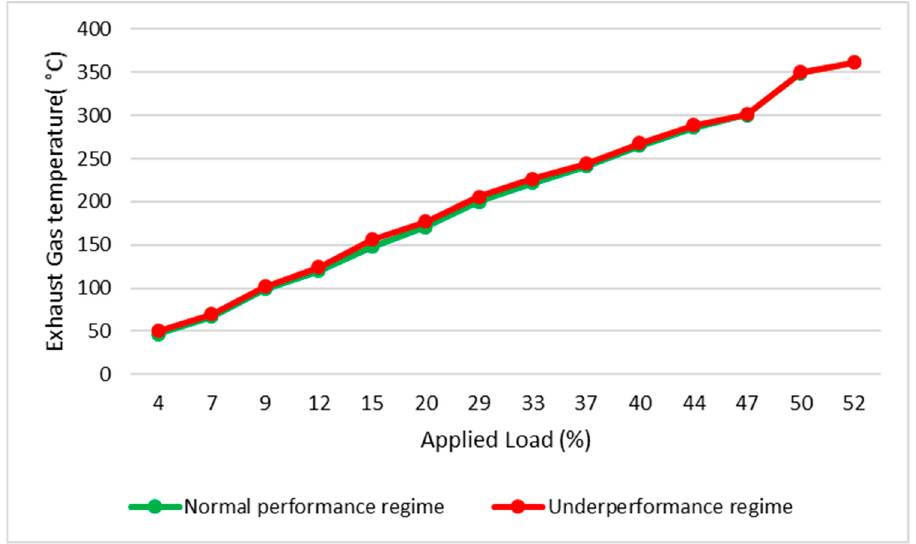
Figure 6. Exhaust gas temperature vs. load.